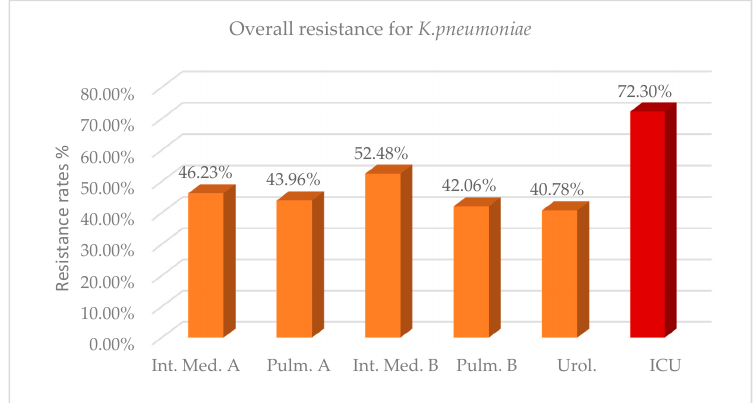
Figure 3. Resistance rates for Klebsiella pneumoniae per ward during the 2-year period (2017–2018).